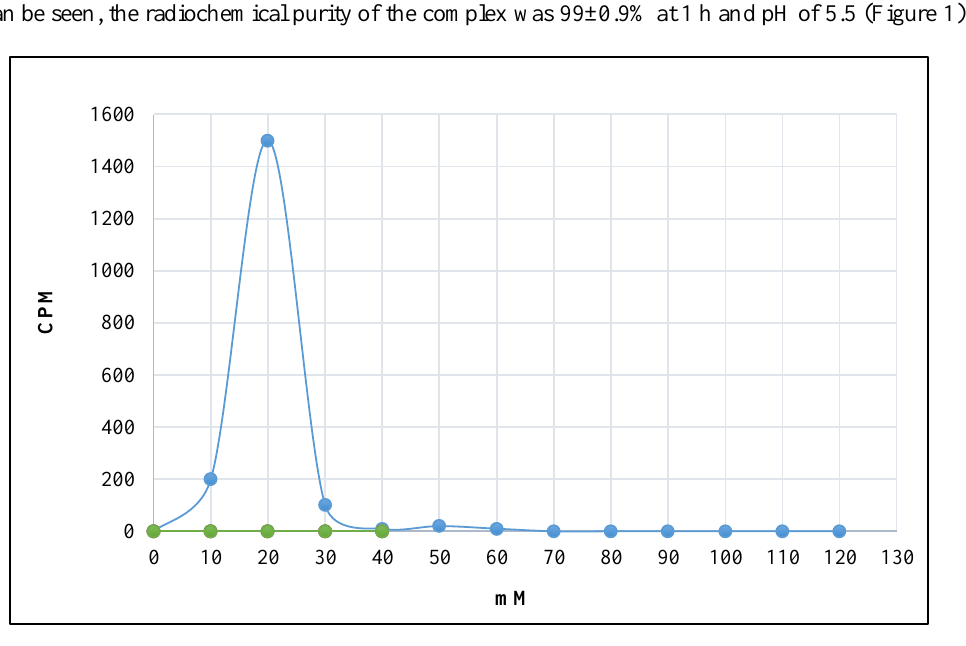
Figure 1. Radiochemical purity of labelling using the relative counts recorded from different segments of the chromatography paper against the distance from the bottom of the